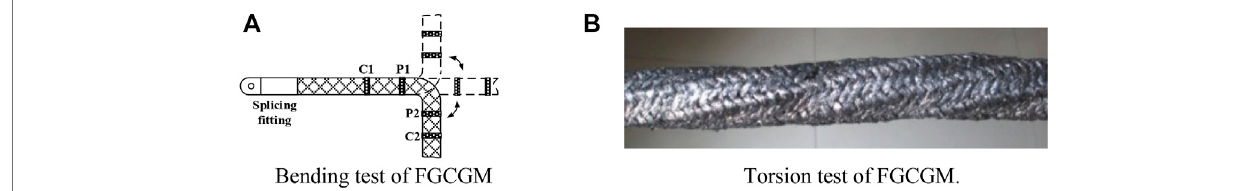
FIGURE 9 | Bending and torsion tests of FGCGM.